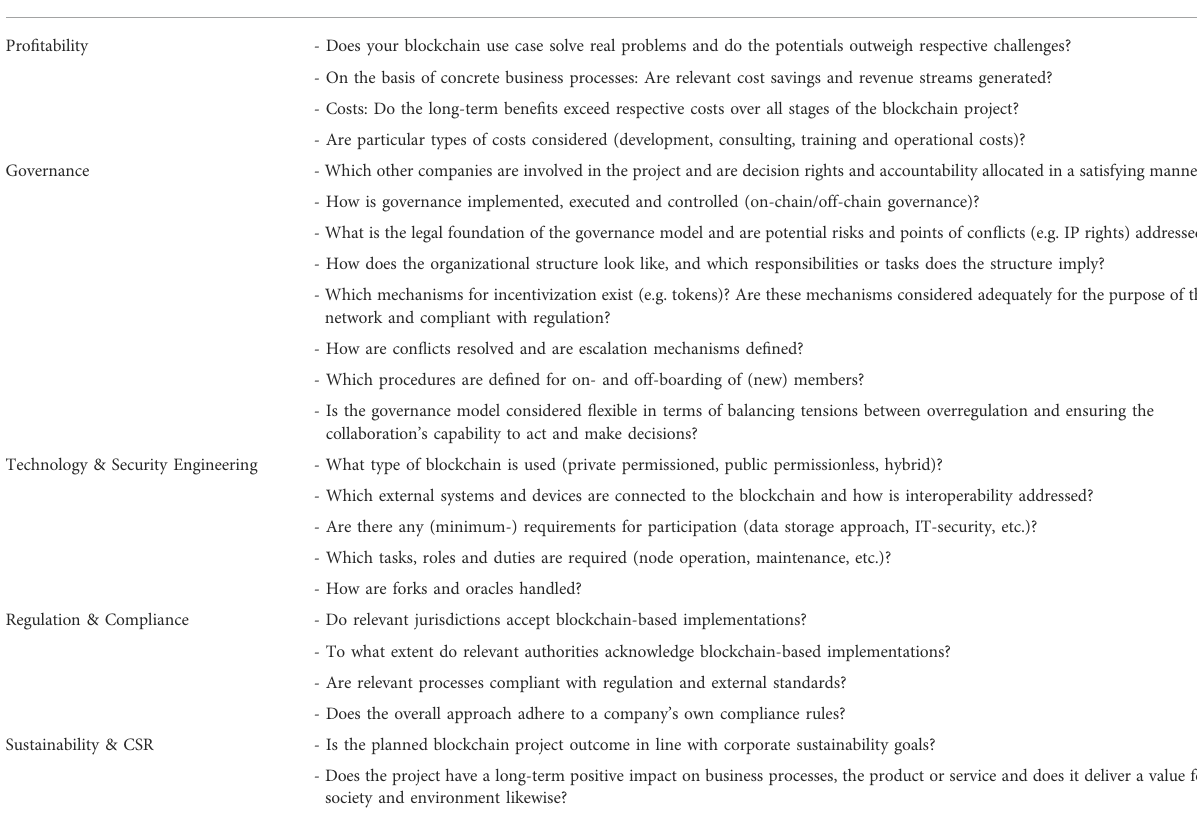
TABLE 1 Possible relevant questions for enterprise blockchain consortium